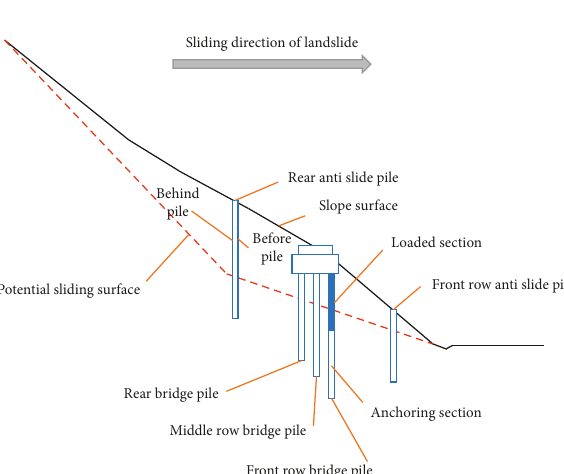
Figure 18: Position relationship of landslide-bridge foundation- antislide pile system.